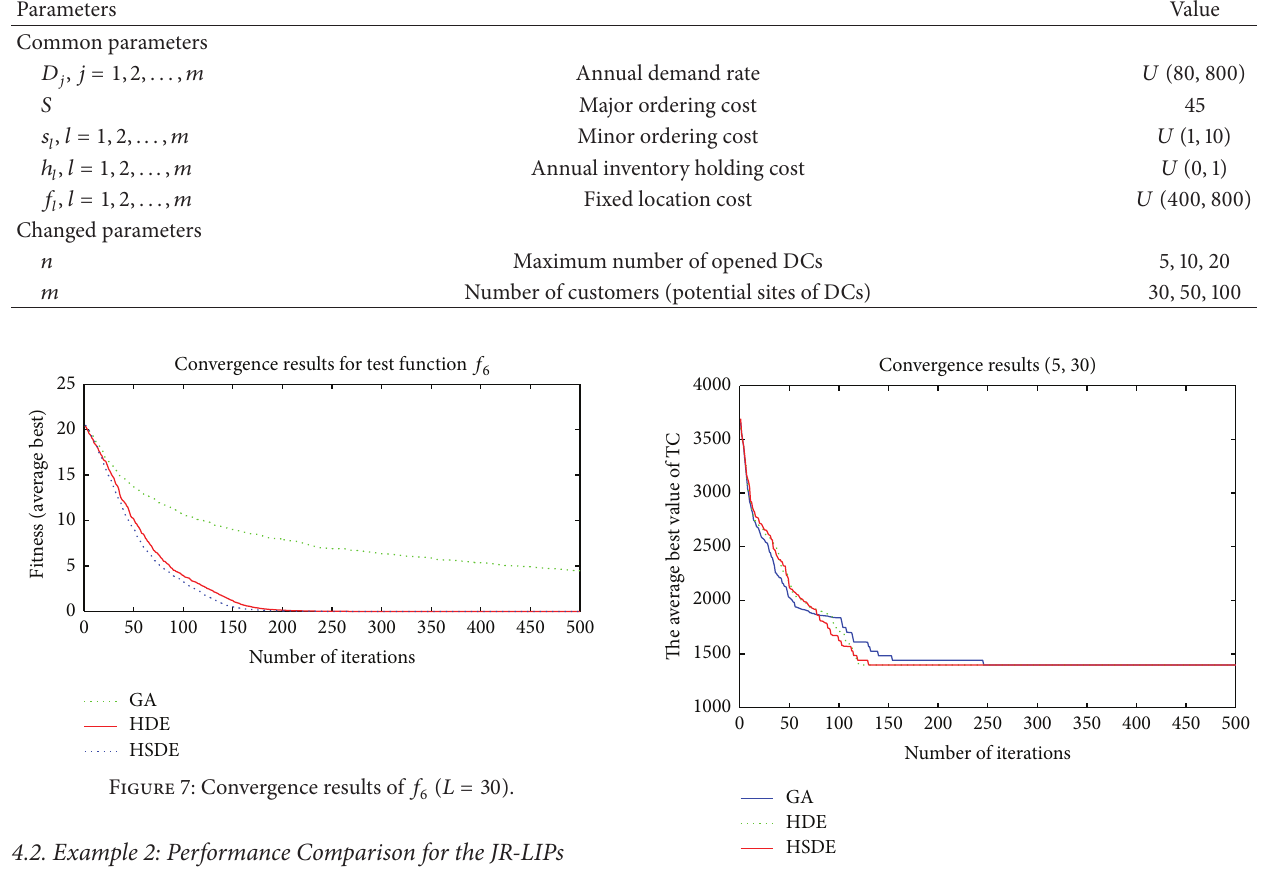
Figure 8: Convergence trend ( 𝑃 5 30).